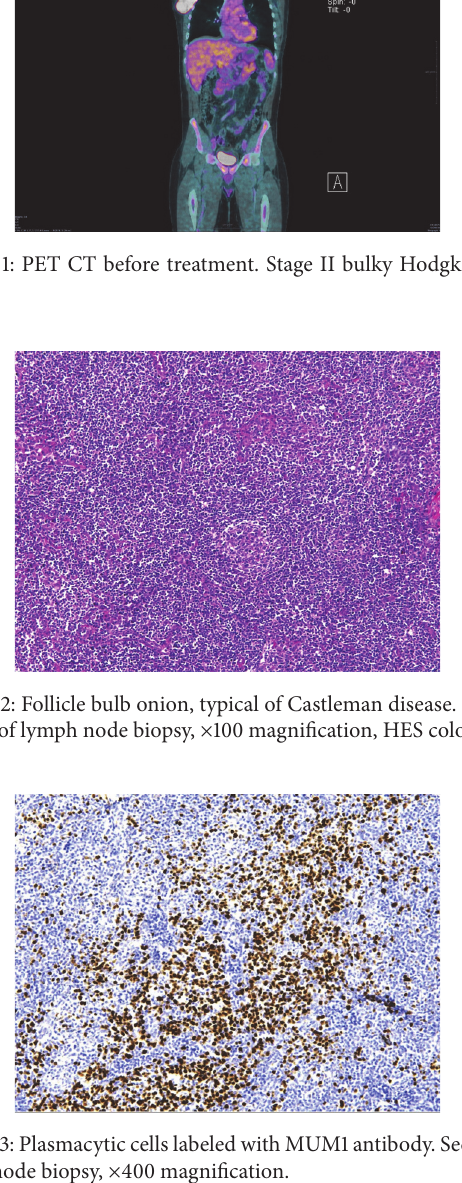
Figure 6: Hodgkin cells. Section of lymph node biopsy, × 400